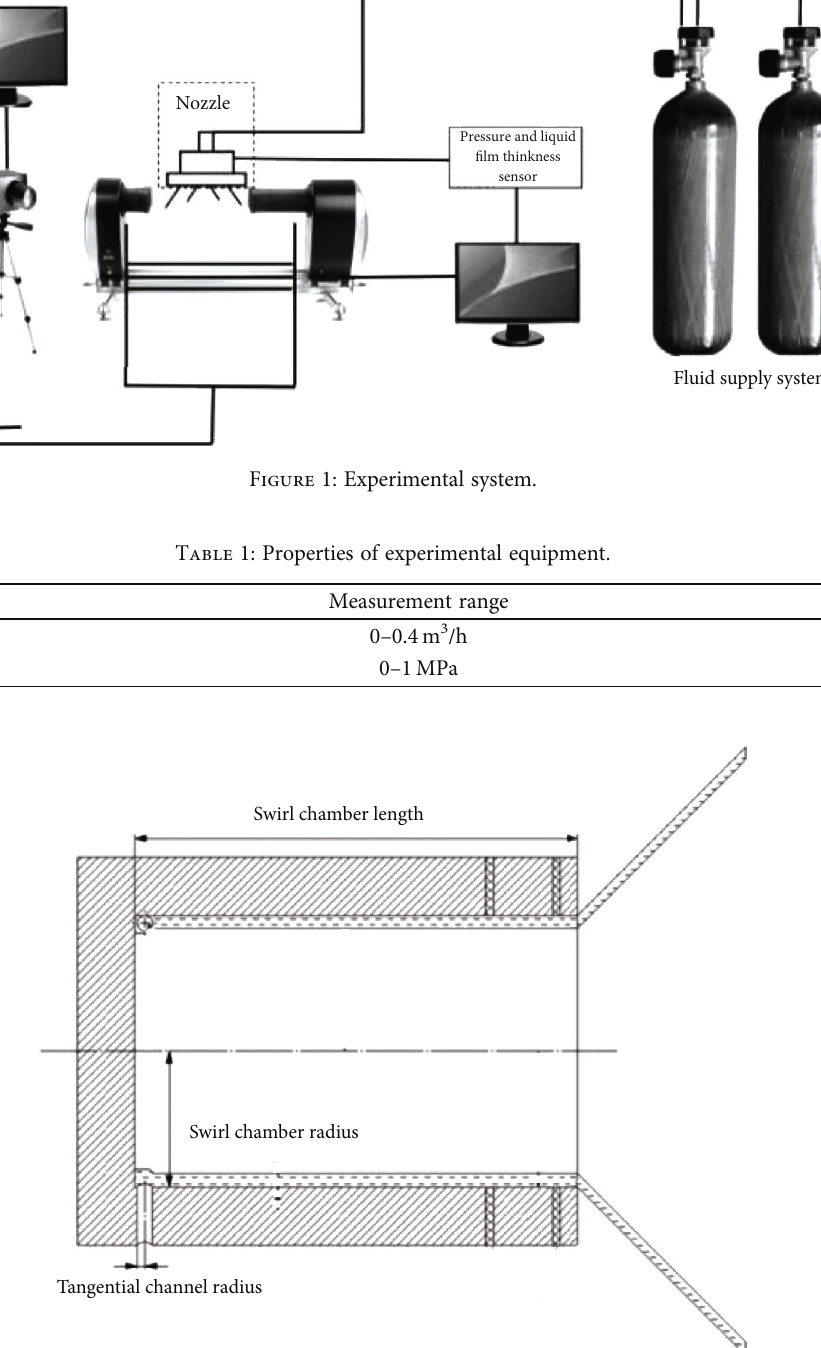
Figure 2: Open-end swirl